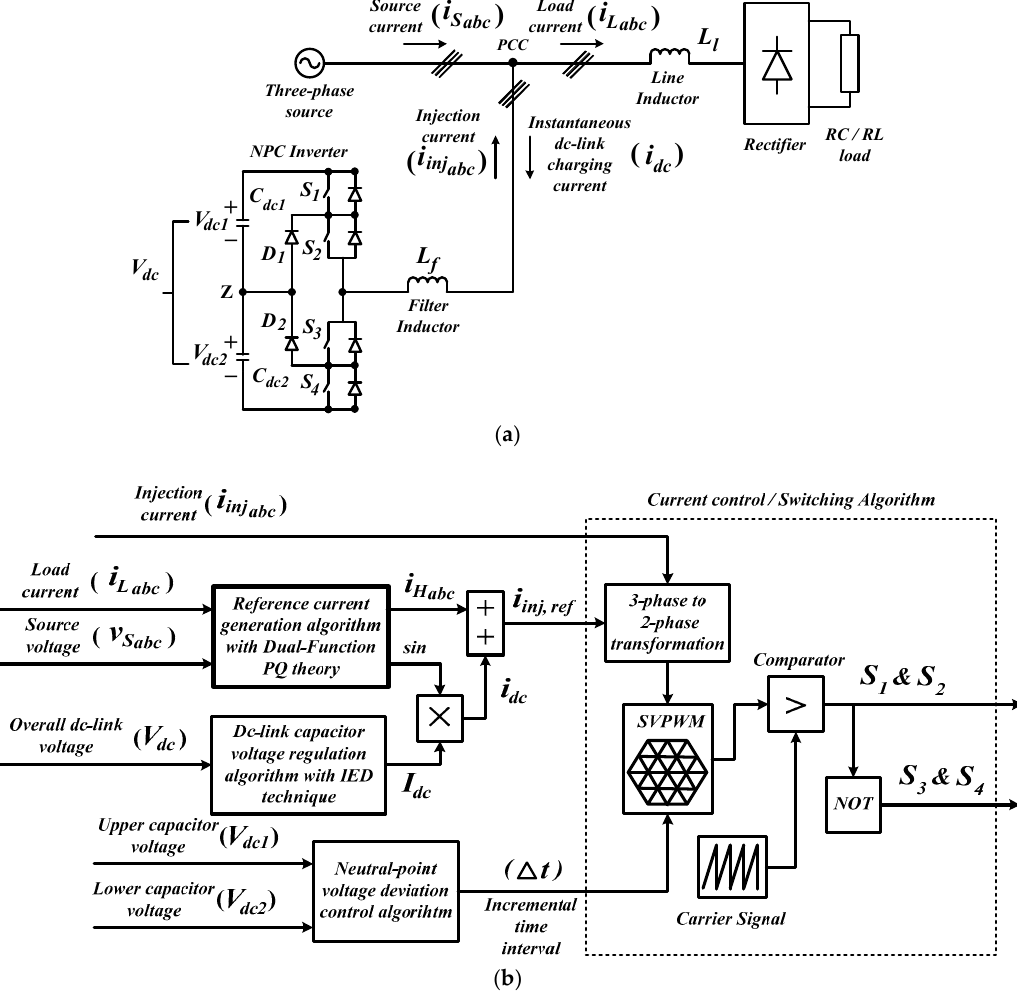
Figure 1. Three-level NPC inverter working as SAPF: ( a ) circuit connection; and ( b ) control algorithms.